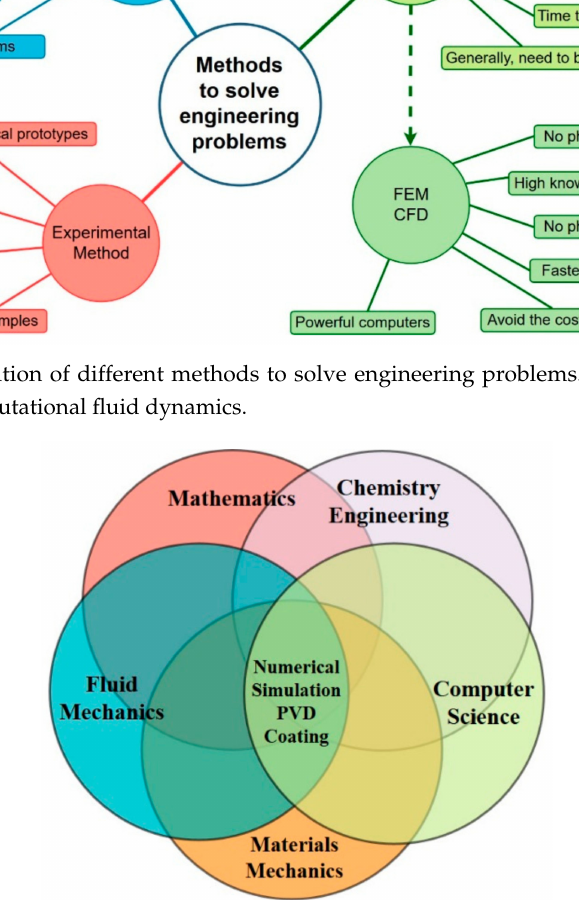
Figure 5. Multidisciplinary nature of numerical simulation methods.